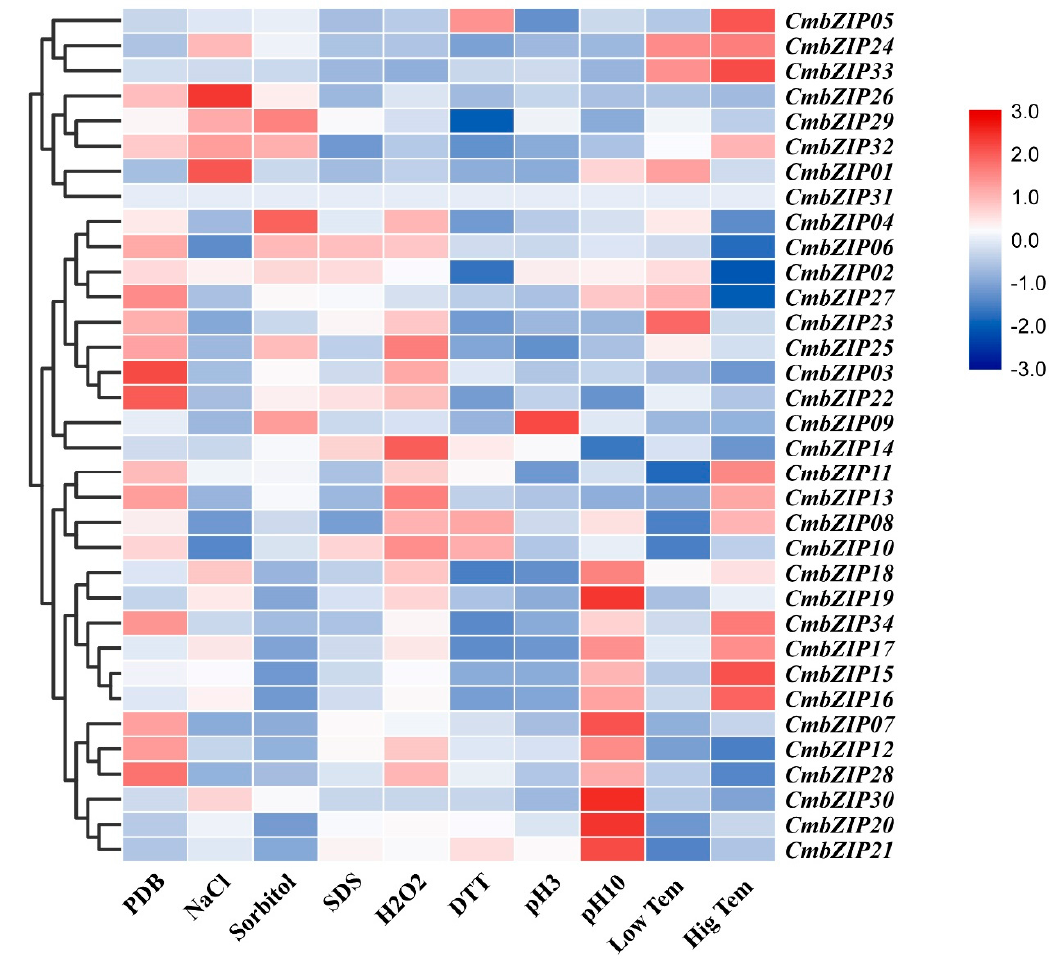
Figure 6. Expression profiles of CmbZIP genes response to abiotic stress. Relative expression values of RT-qPCR results were transformed by log2. Fold changes in gene expression are shown in color according to the scale. PDB: potato dextrose broth, NaCl: sodium chloride, SDS: sodium dodecyl sulfate, H 2 O 2 : hydrogen peroxide, DTT: dithiothreitol, Low Tem: low temperature (4 ◦ C), Hig Tem: high temperature (37 ◦